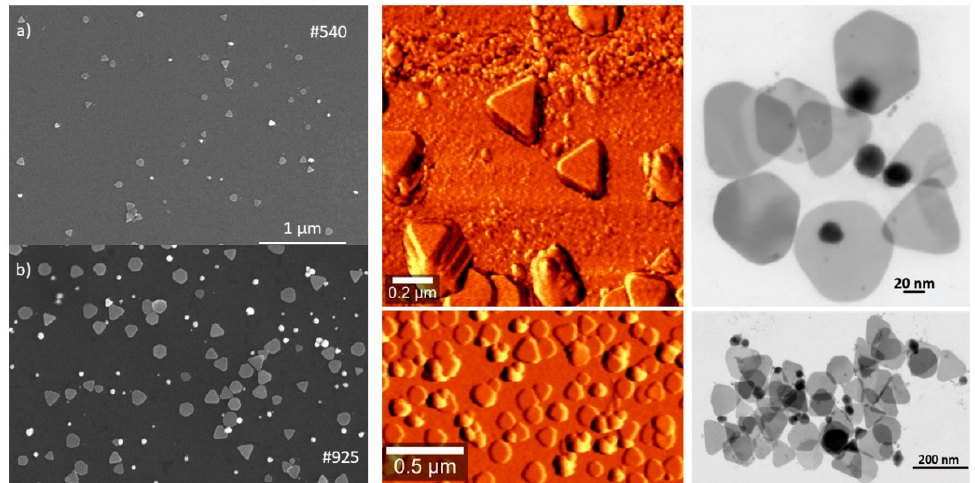
Figure 3. Representative SEM ( a ), AFM ( b ), and STEM ( c ) images from Ag NPT samples #534 and #925 nm.